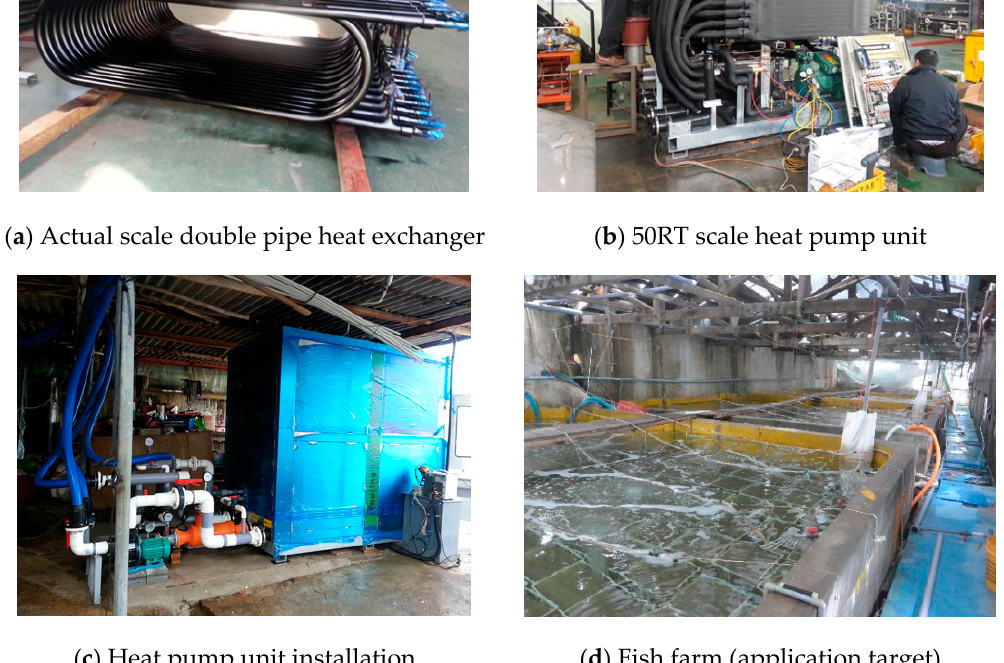
Figure 10. Installation of 50RT scale heat pump on a fish farm for field tests.